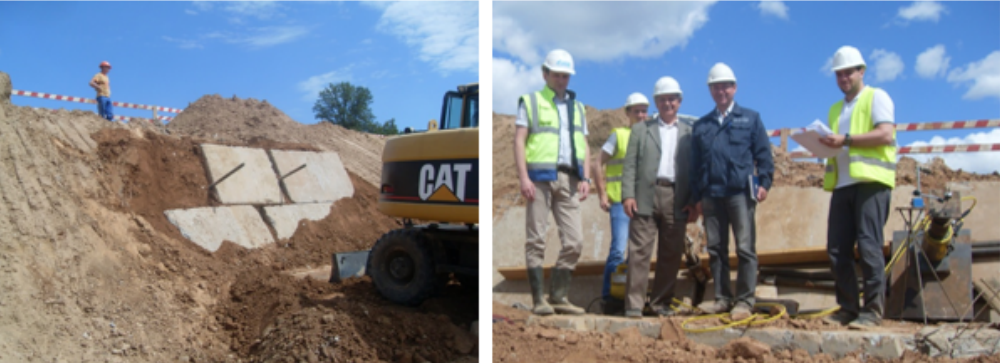
Figure 4. Assembling panels of support system for two experienced anchor piles and sampling testing for one of